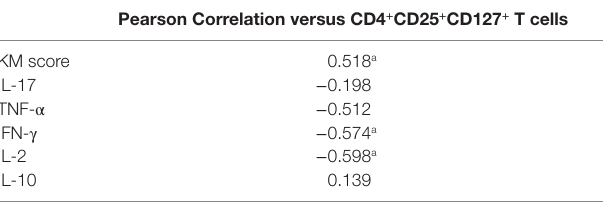
TaBle 4 | Pearson correlation of cD4 + cD25 + cD127 + T cells and infiltrating cytokine producing cells in colorectal tumors ( n = 14). Pearson correlation versus cD4 + cD25 + cD127 + T